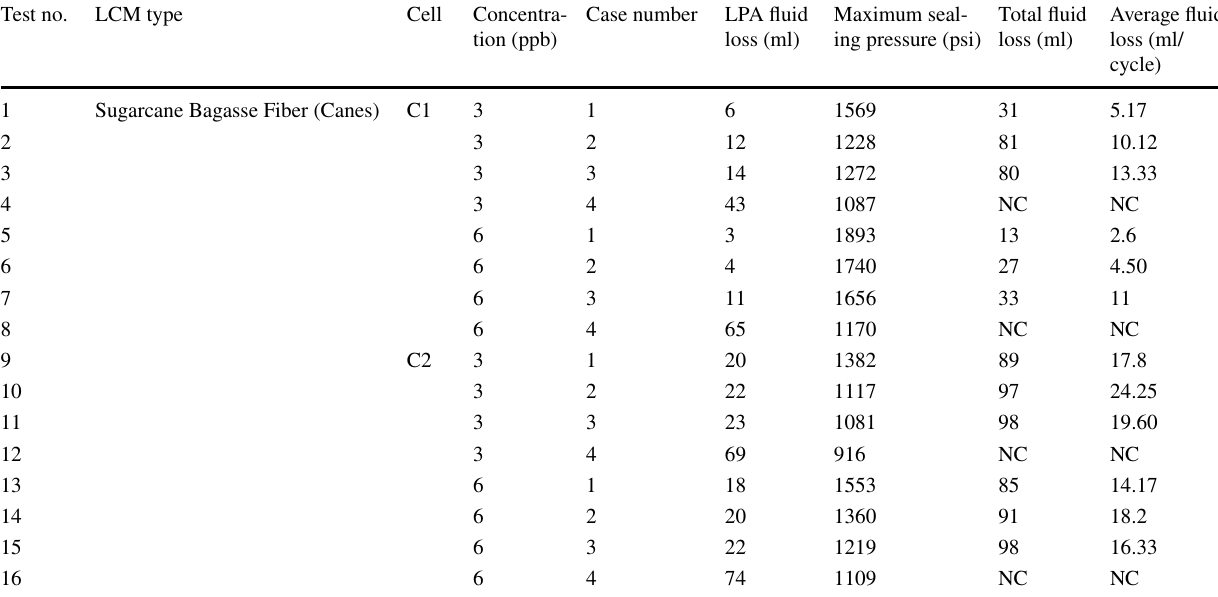
Table 10 Summary of HPA testing results for Sugarcane Bagasse Fiber (Canes) Test